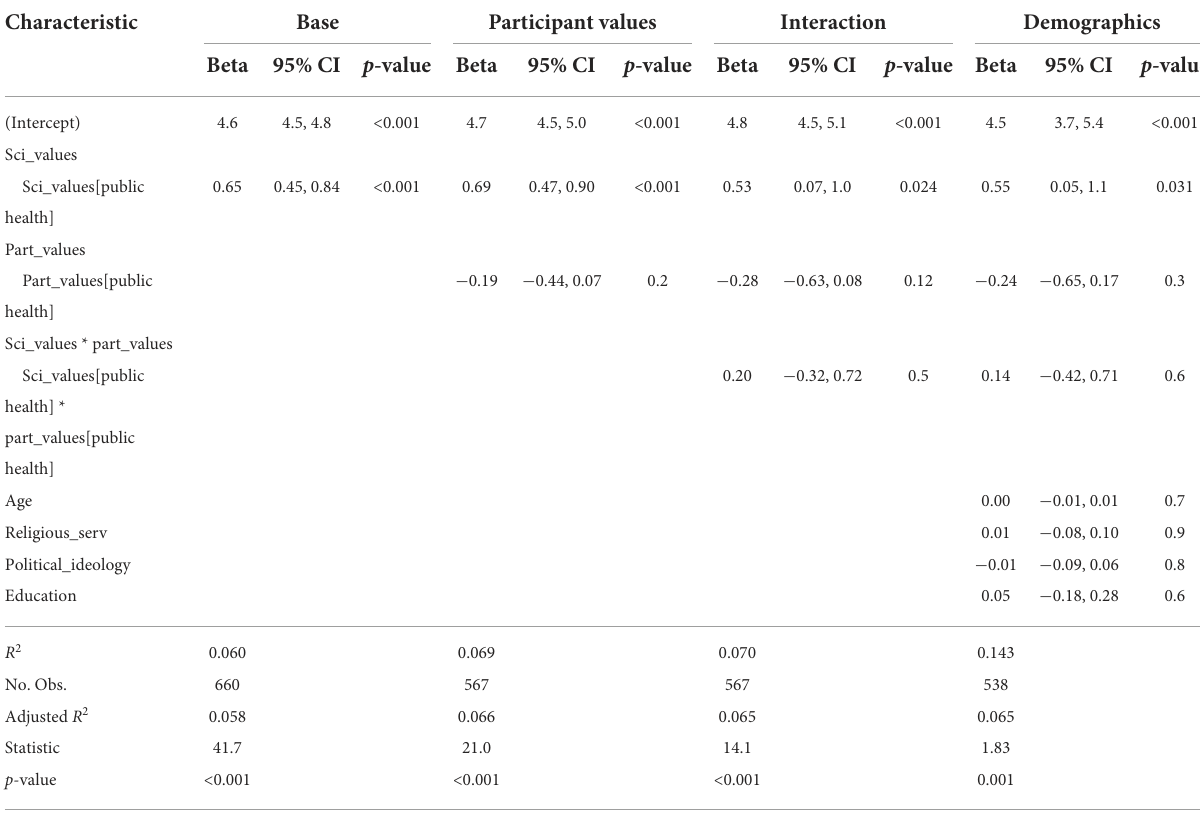
TABLE 6 Regression analysis of interaction between scientist values and participant